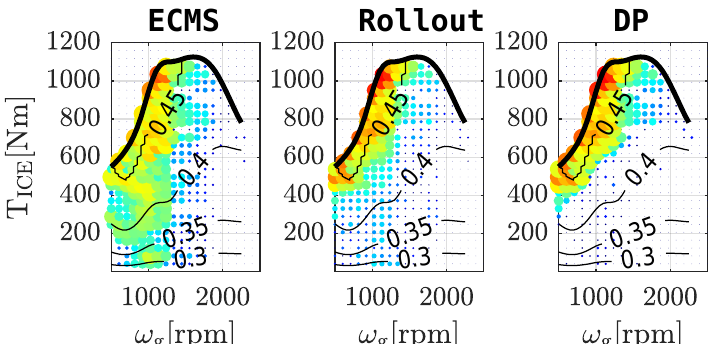
Figure 10. Comparison between the engine operating point histogram obtained with DP assuming a priori knowledge of the route (optimal solution), the proposed online applicable method (rollout) and the standard online applicable method ECMS calibrated with a single